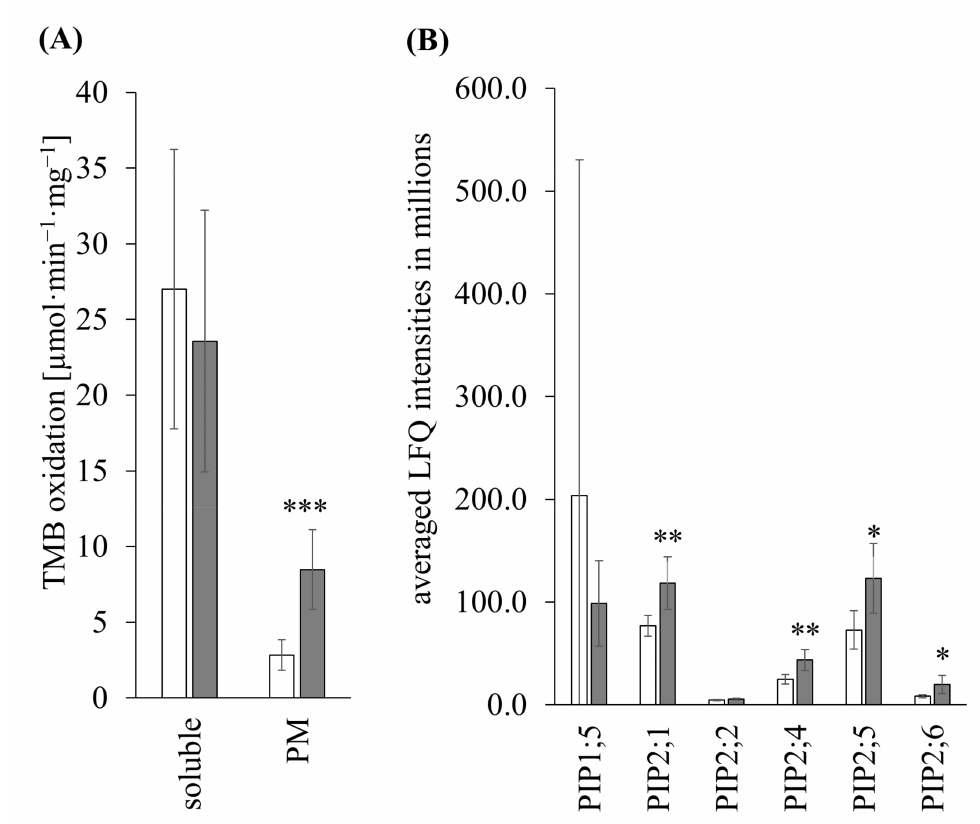
Figure 9. Alteration of PM-bound haem proteins and PIPs. ( A ) For maize root soluble proteins and PMs, the activities of haem and copper-containing proteins were determined spectrophotometrically using the substrates H 2 O 2 and 3,3 (cid:48) ,5,5 (cid:48) -tetramethylbenzidine (TMB). ( B ) Plasma membranes of control and 24 h hypoxia-stressed maize roots were used for mass spectrometry analyses. Label- free quantification (LFQ) data were determined with MaxQuant software and used for further statistical analyses. Control (white columns) and stressed samples (gray columns) were shown. Error bars indicate standard deviation. Significances are indicated with asterisk ( p < 0.05 *, p < 0.01 **, p < 0.001 ***) determined with Student ´ s t -test for TMB oxidation ( n > 4 biological replicates and n = 3 technical replicates) and for shotgun ( n = 3 biological and n = 2 technical replicates per